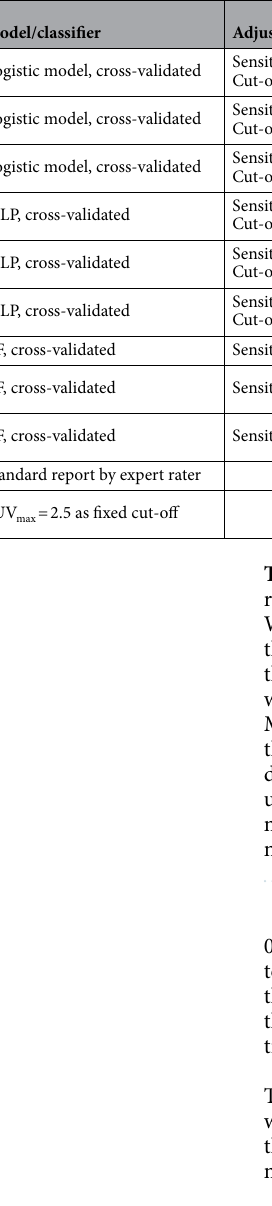
McNemar’s test for comparison of the row heading classifier with False negatives standard report by expert rater